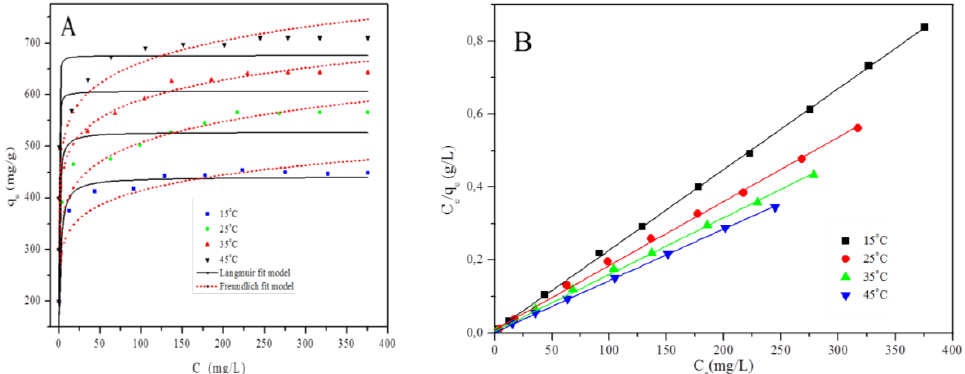
Figure 7. Isotherm data to the Langmuir and Freundlich models ( A) and Isotherm data to the linear form of the Langmuir model for Cr(VI) adsorption ( B) by PPy- m PD/Fe 3 O 4 nanocomposite adsorbent. Table 1. Isotherm parameters for Cr(VI) adsorption by PPy– m PD/Fe 3 O 4 using both Langmuir and Freundlich models.